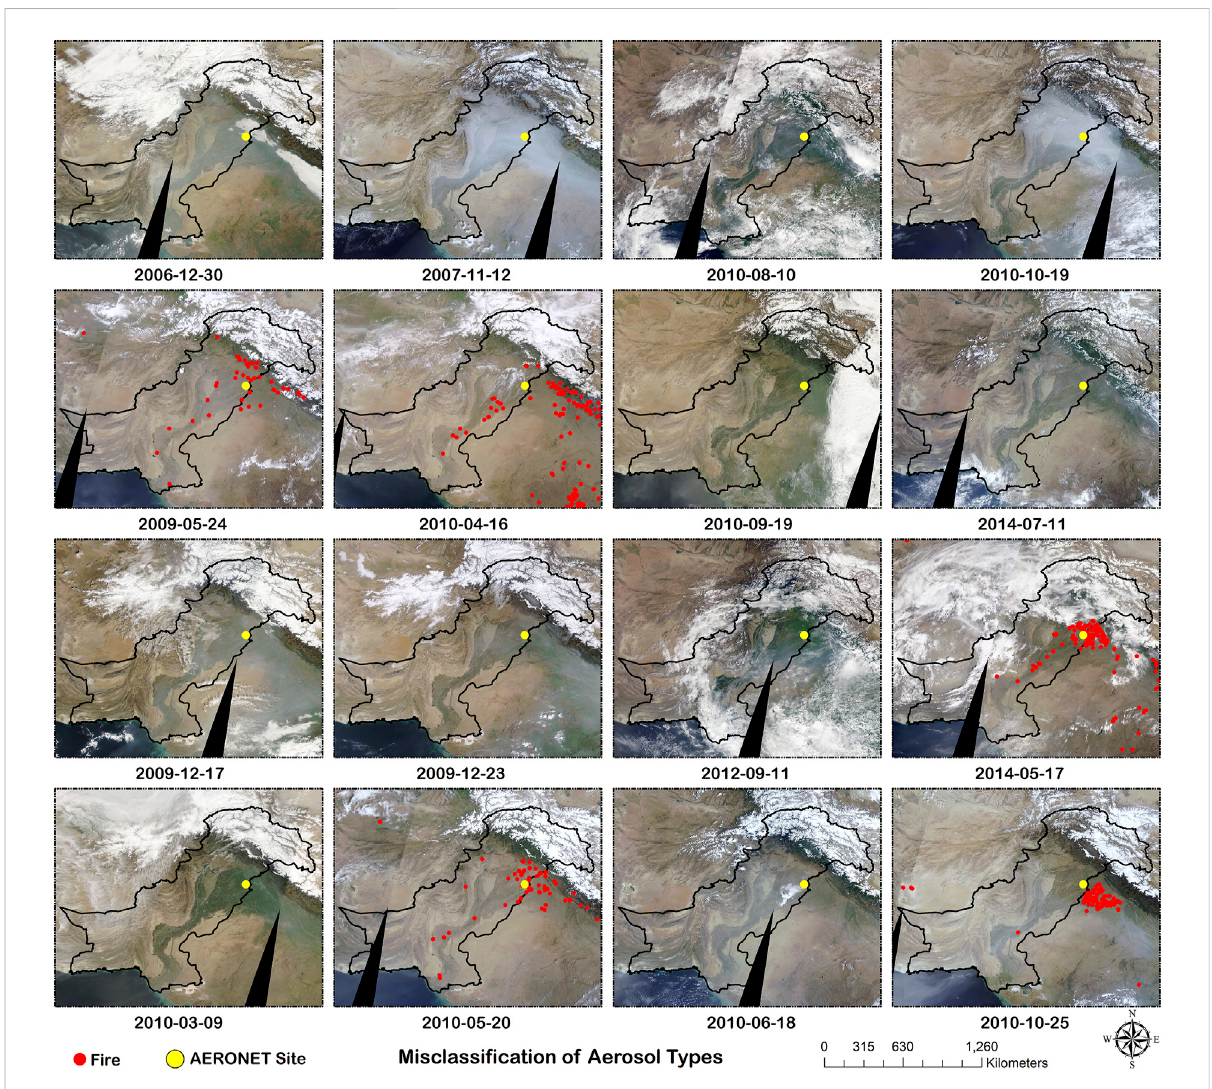
FIGURE 2 MODIS true-color composite images with MODIS thermal/ fi re anomaly data overlaid (red dots). The Lahore AERONET site is indicated with a yellow dot. Rows 1,2,3, and 4 are examples of incorrect classi fi cations of BB, DD, CC, and CM aerosol types, during known aerosol